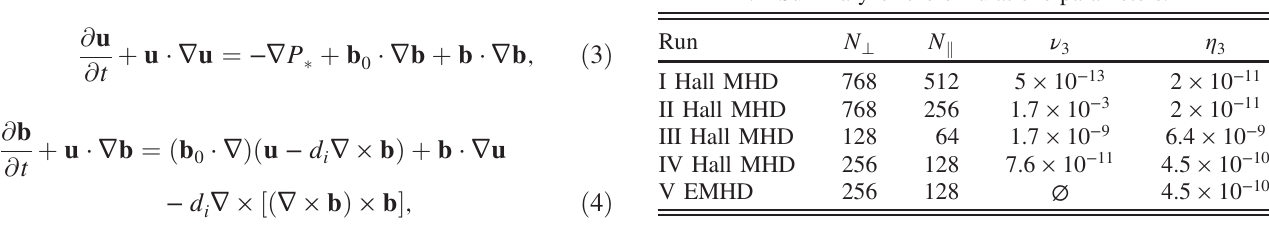
TABLE I. Summary of the simulations